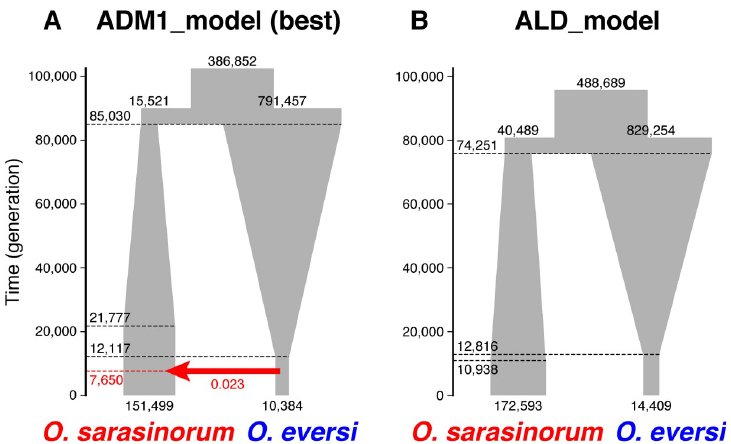
Fig 5. Schematic illustration of (A) ADM1_model (the best model) and (B) ALD_model estimated by fastsimcoal2 runs. The model is drawn to scale (time in generations) and population sizes; however, growth was modeled to be exponential and not linear as depicted here. The red arrow represents admixture.